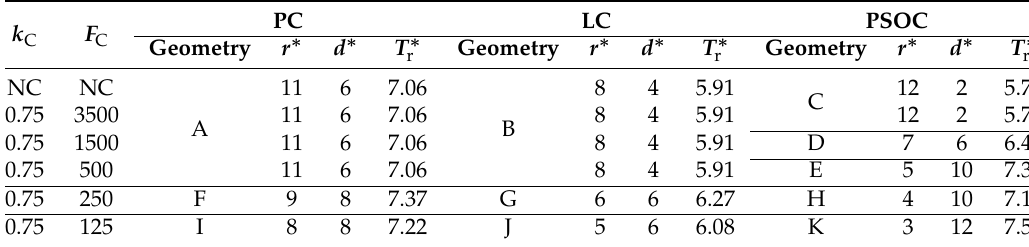
Figure 8. Absorbed power by the cylinders with oscillation amplitude constraints ( k C = 0.75) and force constraints ( F C = 500 kN): ( a ) PC, ( b ) LC and ( c ) PSOC. Table 1. Optimal values of r (m), d (m) and T r (s) of the cylinders for different constrained control strategies. The PTO is subject to device motion constraints (defined by k C d ) and force constraints (defined by F C in kN). The first line shows the optimal parameters for the unconstrained control cases. NC, not